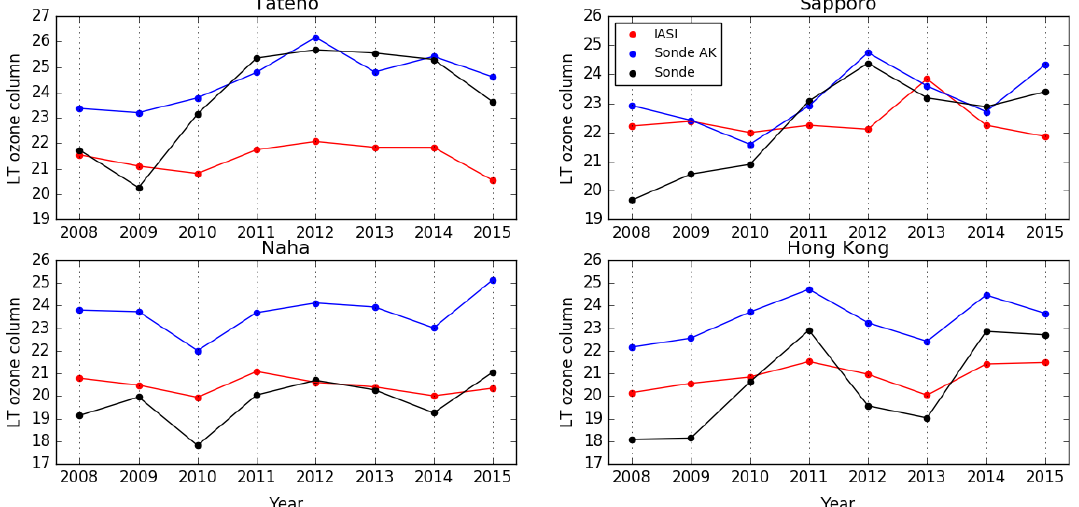
Figure 5. Interannual variations of LT ozone columns observed by IASI (red) and measured by sondes with (blue) and without (black) applying the averaging kernels (AK) for four Asian stations (Tateno, Sapporo, Naha, and Hong